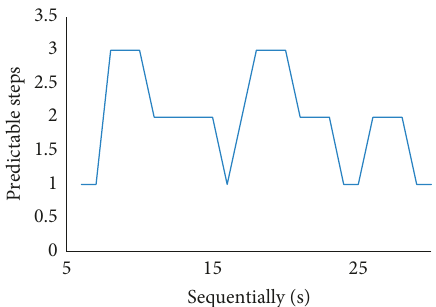
Figure 5: The actual steps for